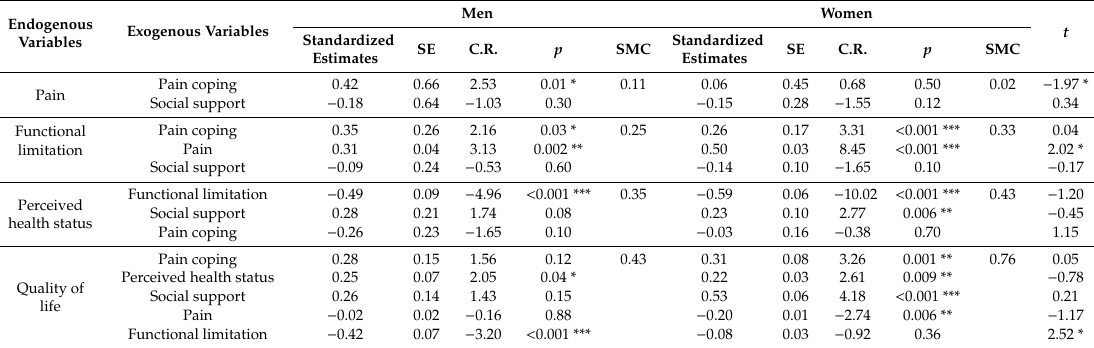
Table 6. Comparison of path coe ffi cients between